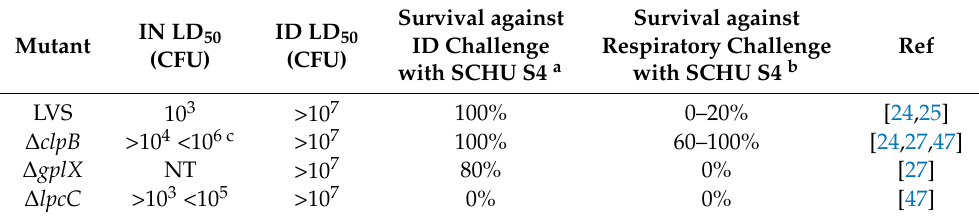
Table 1. Selected characteristics of F. tularensis strains used in the current study. IN LD 50 Mutant